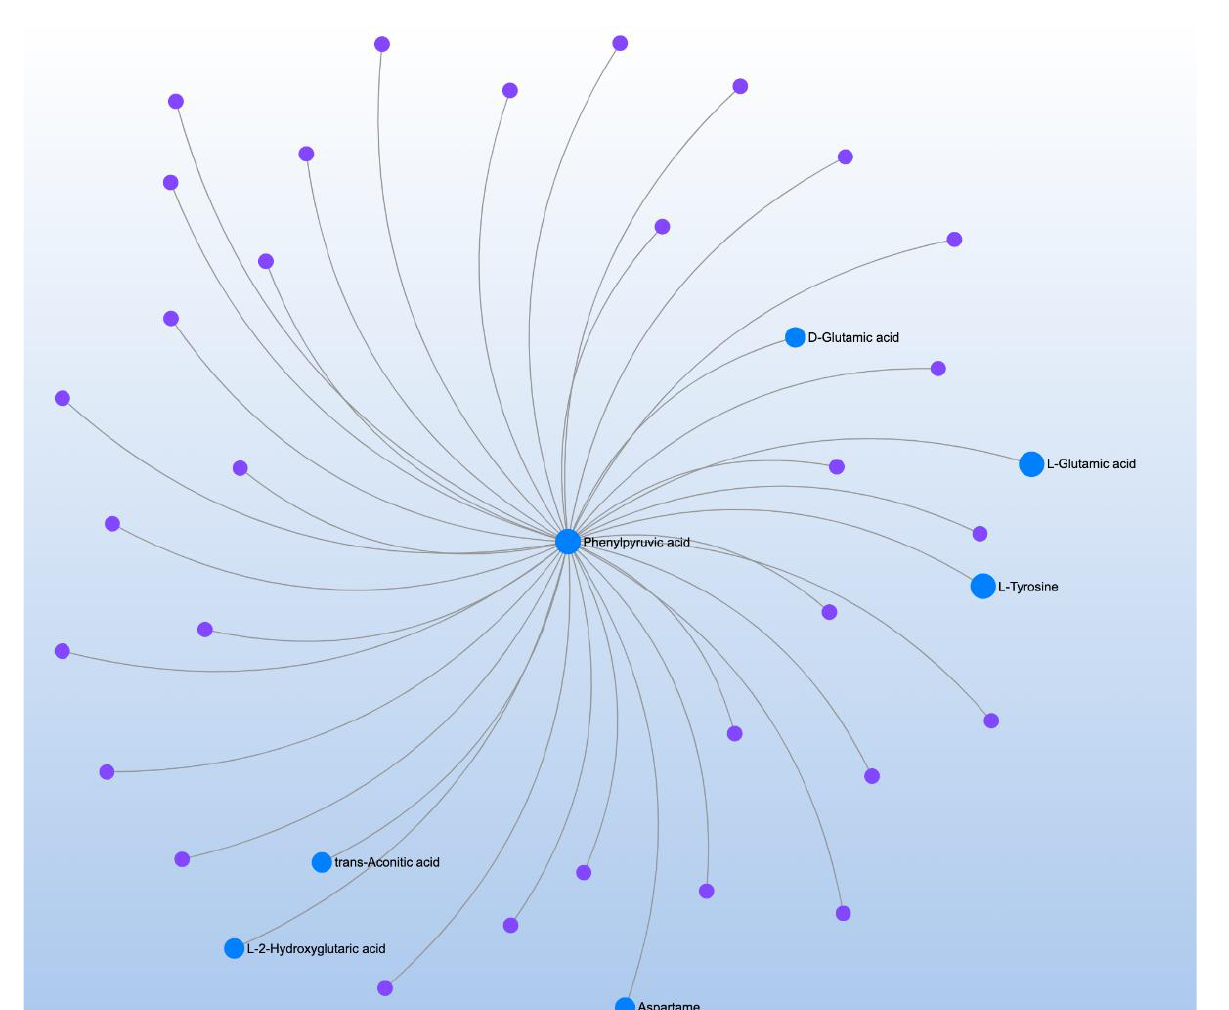
Figure 10. Metabolite-metabolite interaction network for significant metabolites that correlate to free glutathione redox. Size of the node indicates importance in the network. The interaction analysis highlights the importance of phenylpyruvic acid, implicating phenylalanine metabolism. iGSH-GSSG was correlated with 7 metabolites and mapped to one pathway (Table 13). Metabolite-metabolite interaction analysis identified alpha-ketoisovaleric acid (keto acid), cytidine (a component of RNA), citrulline (non-essential amino acid), 5-aminolevulinic acid (responsible for heme production in mammals), and L-alpha-aminobutyric acid (product of the catabolism of methionine, threonine, and serine) as central metabolites (Figure